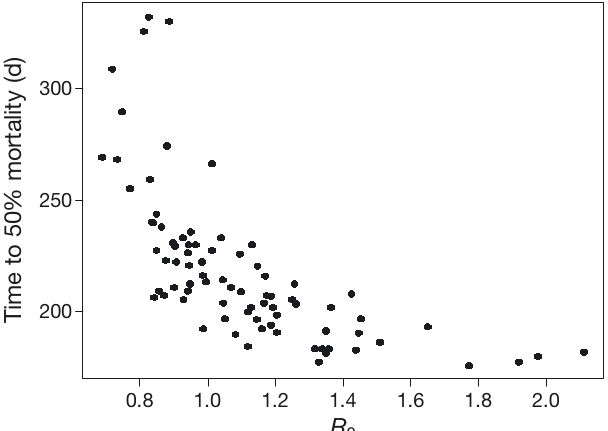
Fig. 9. Simulations with REF conditions run with epidemio- logical parameters drawn randomly from the observed dis- tributions. Each dot represents a simulation, and the time to obtain 50% mortality was plotted against the contagion